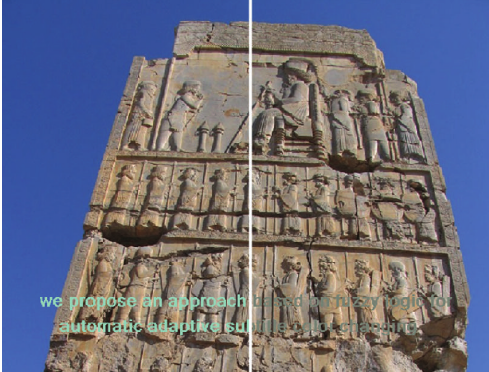
Figure 9: The background image with the centroid values: R = 129, G = 121, and B = 133. (The Glory of Persepolis built in about 500 BC, Iran).